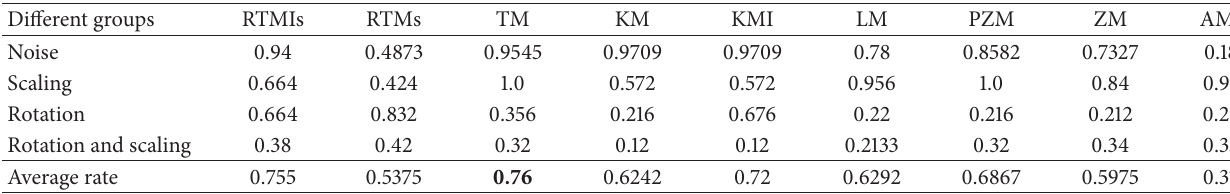
Table 5: Average recognition rates of different